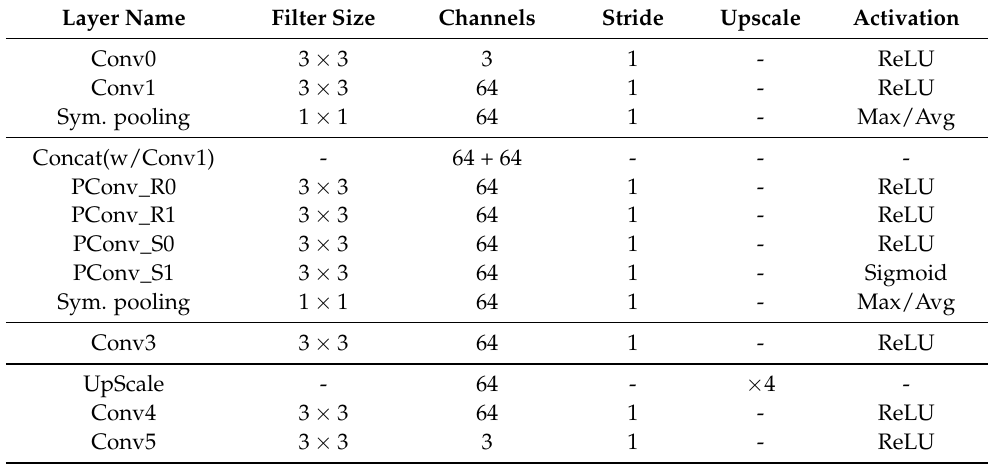
Table 1. Permutation invariant residual network (PIRN)